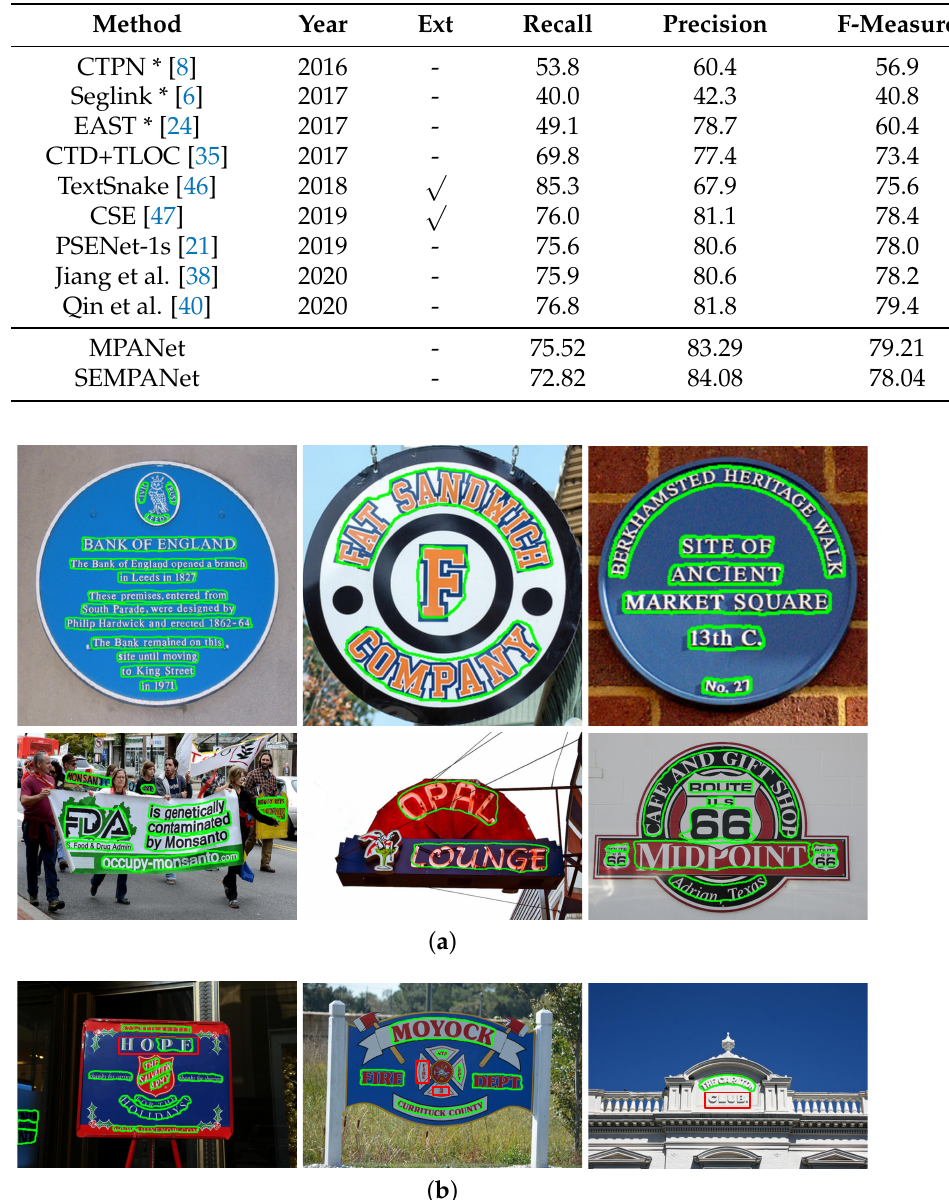
Table 5. The single-scale results from CTW1500. * indicates the results from [35]. Ext is short for external data used in the training stage. MPANet is a model without an SE module.